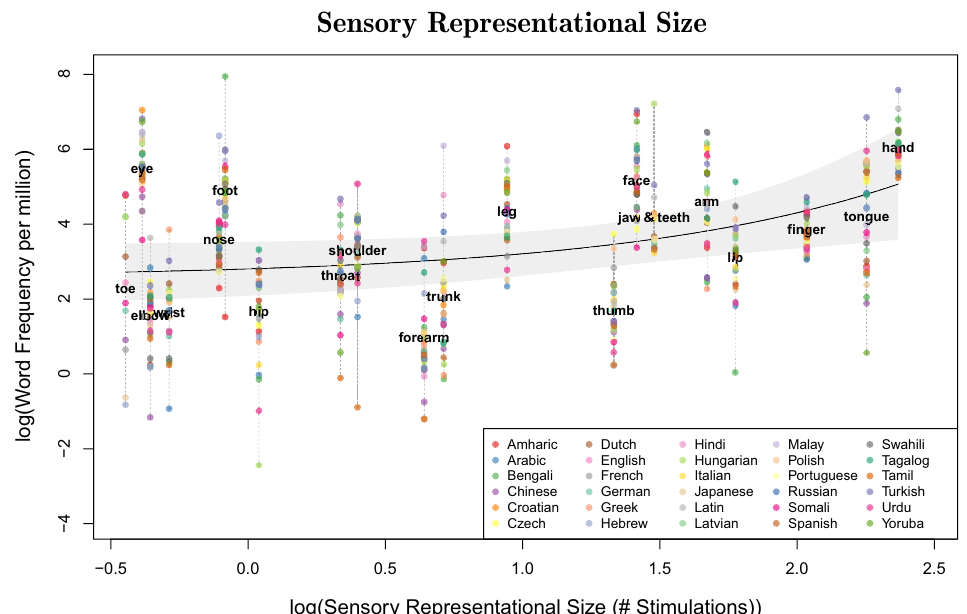
Figure 3. Relation between logarithmic word frequency per million and body surface area ( upper panel ) or sensory representational size ( lower panel ), as measured by the number of stimulation points eliciting a tactile senstation (Penfield and Boldrey 16 ). For visual clarity, the x-axes are displayed on a logarithmic scale. The solid lines indicate model predictions, the gray bands around it 0.95-confidence